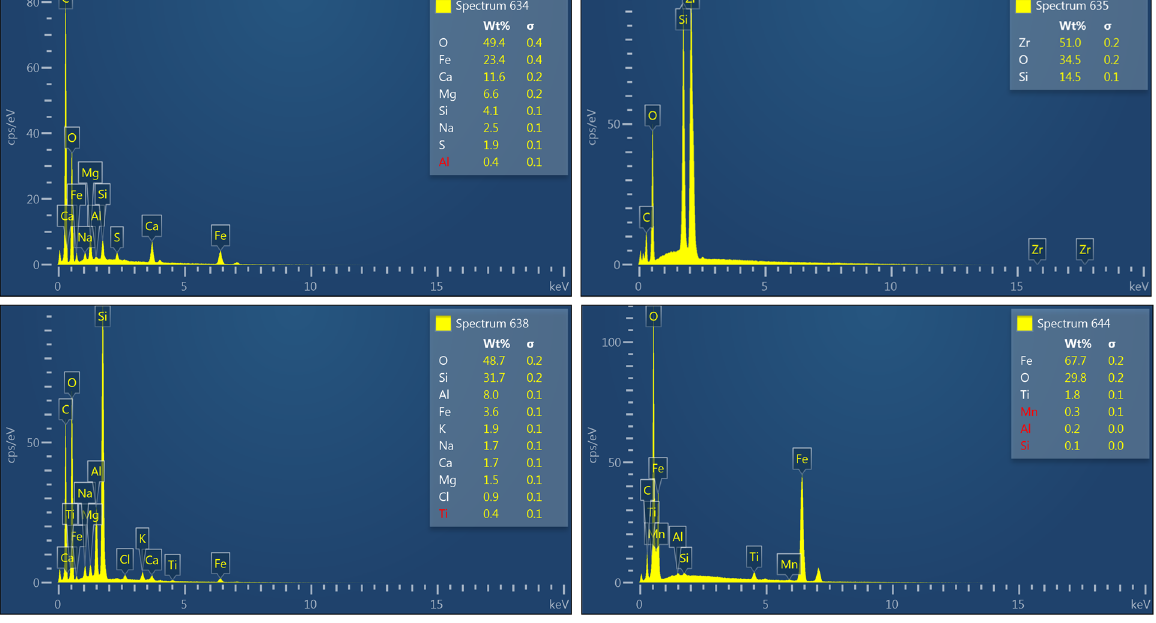
Figure 16. SEM-EDS spectrums that are indicated in Figure 15. Elements listed in red are below the SEM-EDS detection limit.